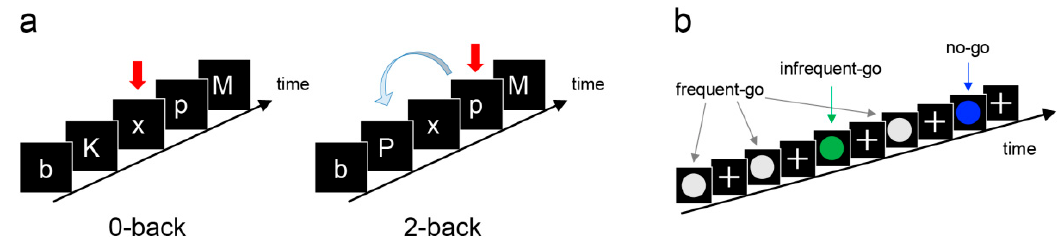
Figure 1. Schematic illustration of fMRI tasks. ( a ) N-back task. Participants should identify target letters (red arrow), which is the letter “x” (0-back condition) or the repeated letter that was shown 2 steps earlier (2-back condition). ( b ) The Go-Nogo task contained three types of trials: frequent-go, infrequent-go, and no-go trials. Participants should respond with button press in (frequent/infrequent) go trials and should not respond in no-go trials.